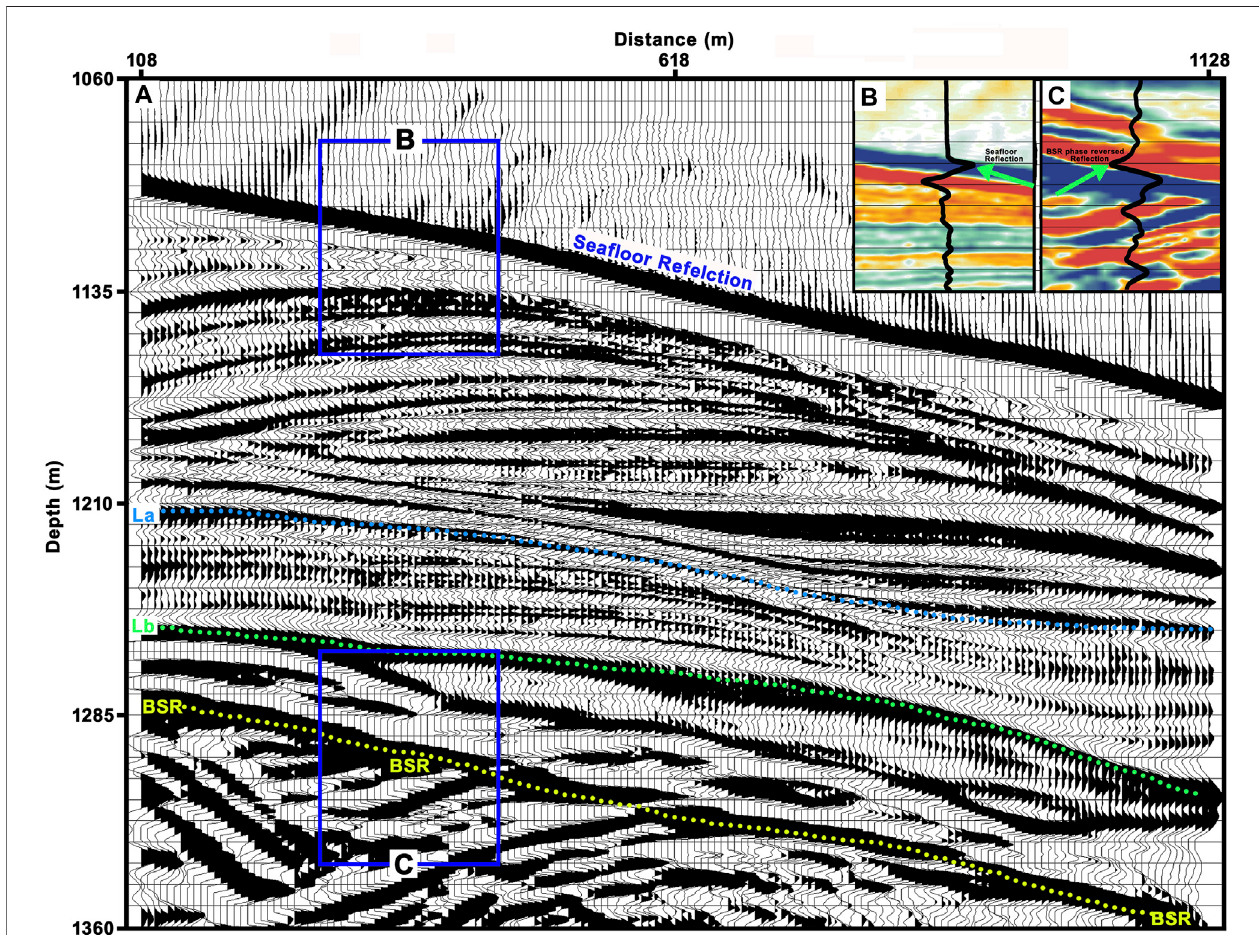
FIGURE 9 | (A) The RTM imaging section with velocity model shown in Figure 8 . The yellow dotted line shows the BSR. (B) Closeup view shows the signature of sea fl oor re fl ection. (C) Closeup view shows the signature of bottom simulating re fl ector (BSR) which is phase reversed re fl ection.